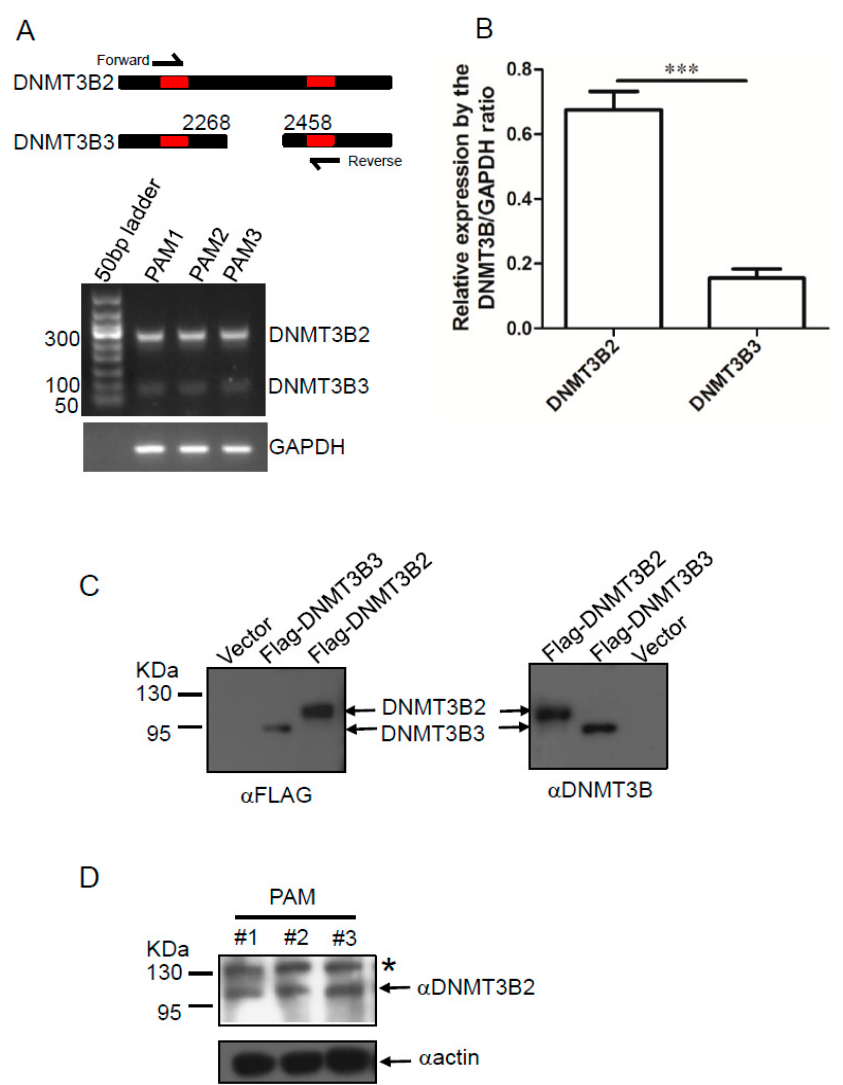
Figure 2. ( A ) Total RNA was extracted from PAM and analyzed by RT-PCR with exon 20 forward primer and an exon 23 reverse primer for the expression profile of DNMT3B2 and DNMT3B3 in PAM. Note that two fragments were obtained: one is more than 250 bp, representative expression of DNMT3B2; another is less than 100 bp, representative of DNMT3B3. ( B ) Furthermore, the bar graph represents relative expression of DNMT3B2 or DNMT3B3 by calculating the DNMT3B2/GAPDH ratio. The data shown are mean (SD) ( n = 3), ***, p < 0.001. ( C ) HEK 293T cells were transiently transfected with recombinant plasmids expressing Flag-pDNMT3B2 and Flag-pDNMT3B3, respectively. Cell lysates were analyzed by Western blot with anti- p DNMT3B or anti-Flag antibodies. ( D ) The expression profile of DNMT3B in PAM was analyzed by Western blot. Note that only DNMT3B2 was detected in PAM. * is representative of nonspecific reaction.